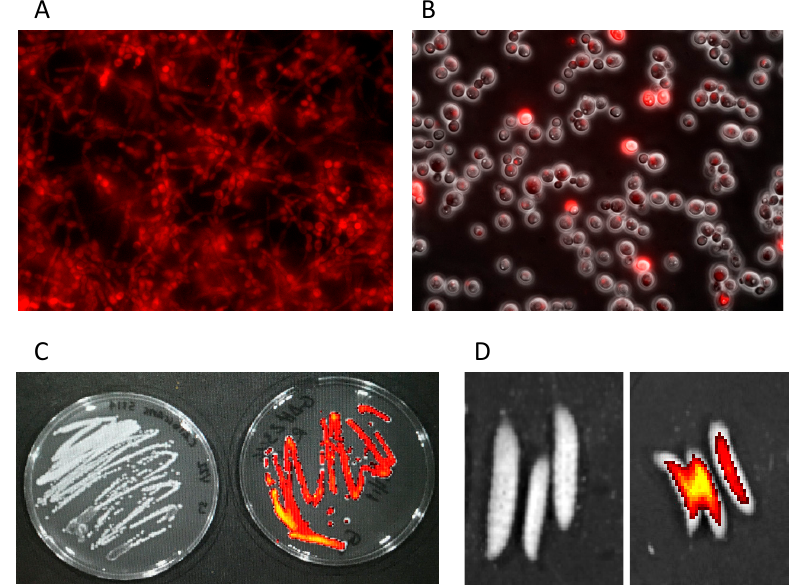
Figure 1. Visual imaging of C. albicans GDH2346. ( A ) GDH2346-RFP, grown for 24 h in hyphal permissive media, wet slide image on fluorescent microscope (40 × magnification). ( B ) GDH2346-RFP yeast cells imaged with light phases and fluorescent microscopy, showing RFP expression (63×). ( C ) 24-h cultures of C. albicans SC5314 (left) and GDH2346-RFP (right), grown on YPD agar plates, and visualized in the IVIS. ( D ) G. mellonella , injected with PBS (left) or C. albicans GDH2346-RFP (right) after 24 h, visualized in the